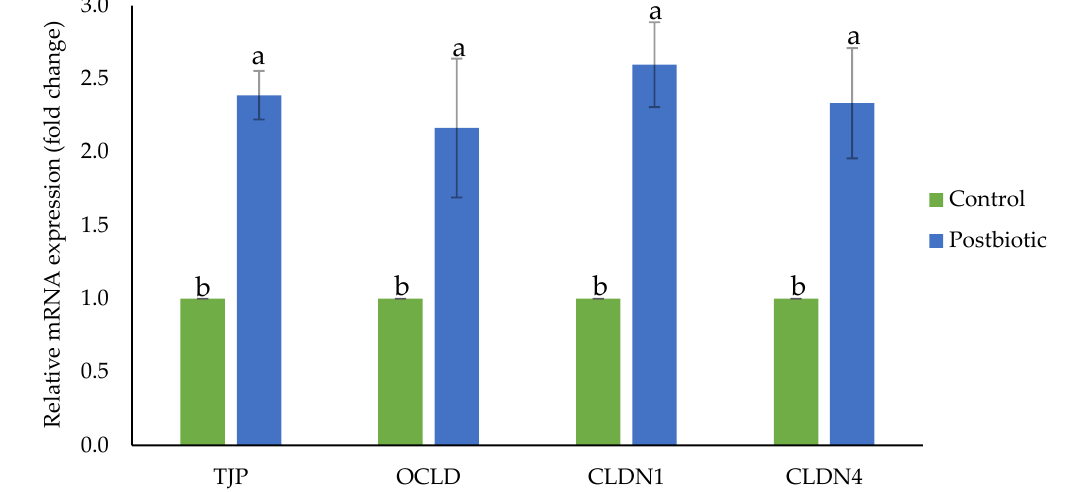
Figure 3. Gene expression of the ruminal barrier function of post-weaning lambs supplemented with and without postbiotic L. plantarum RG14. TJP: Tight junction protein, OCLD: Occludin, CLDN1: Claudin 1, CLDN4: Claudin 4. a,b Bars with different letters between treatment groups are significantly different ( p < 0.05).